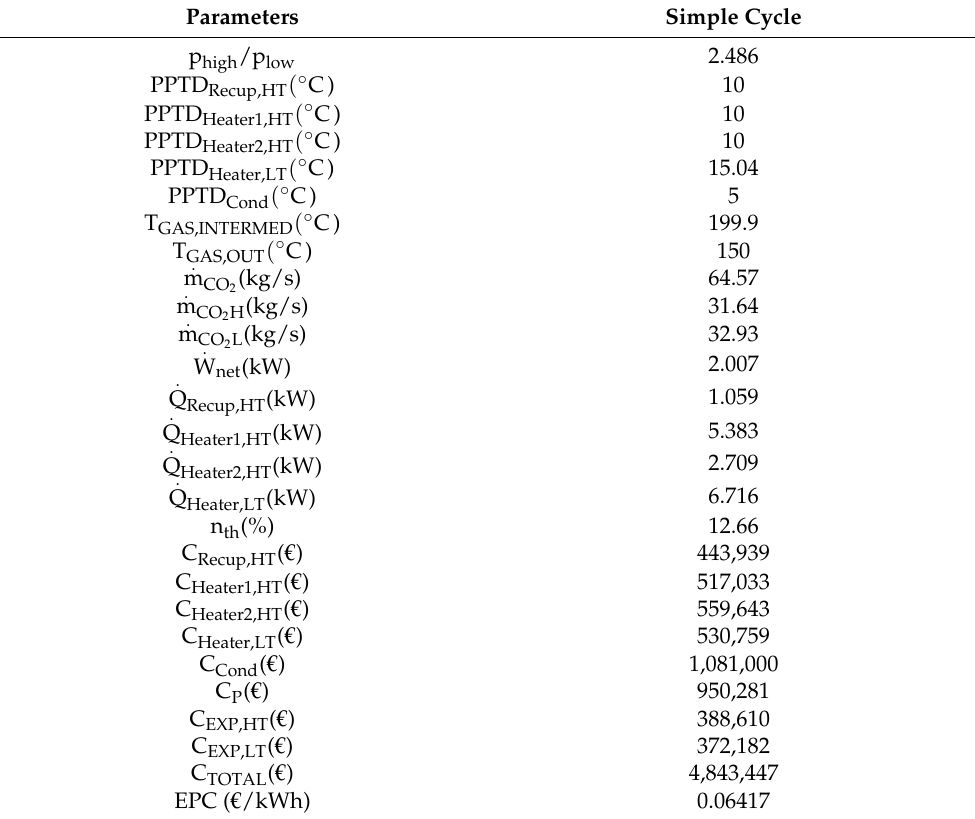
Table 9. Results from the optimization of the cascade cycle with the genetic algorithm. Parameters Simple